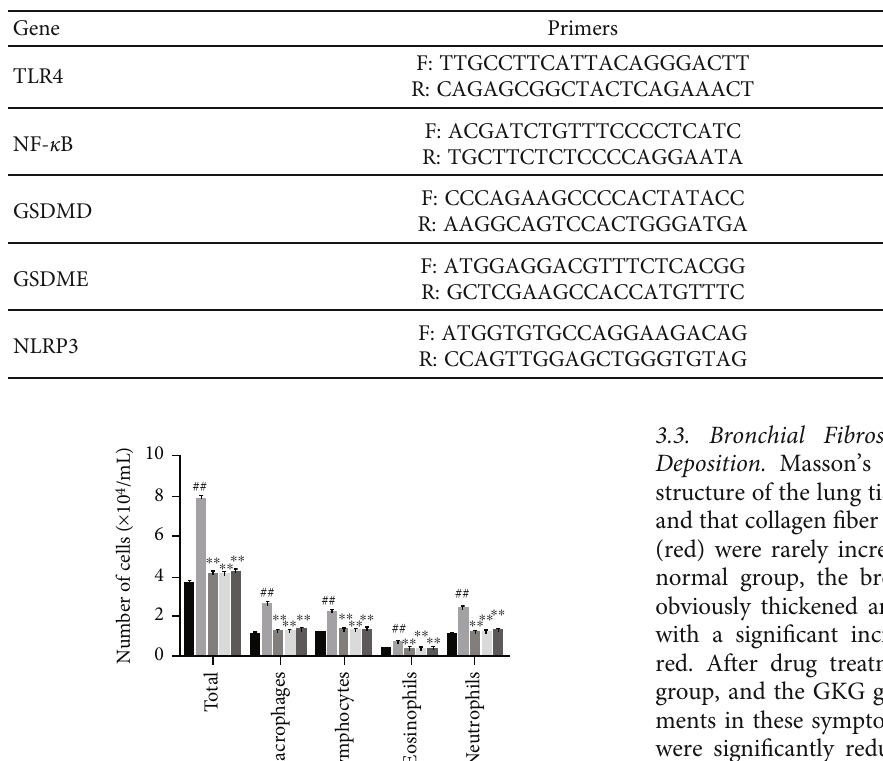
Table 1: Real-time PCR primers.